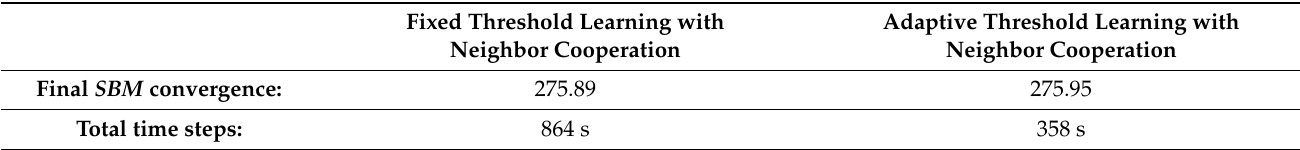
Figure 6. Second learning hierarchy level results compared to learning with a fixed threshold. Table 3. Simulation results.